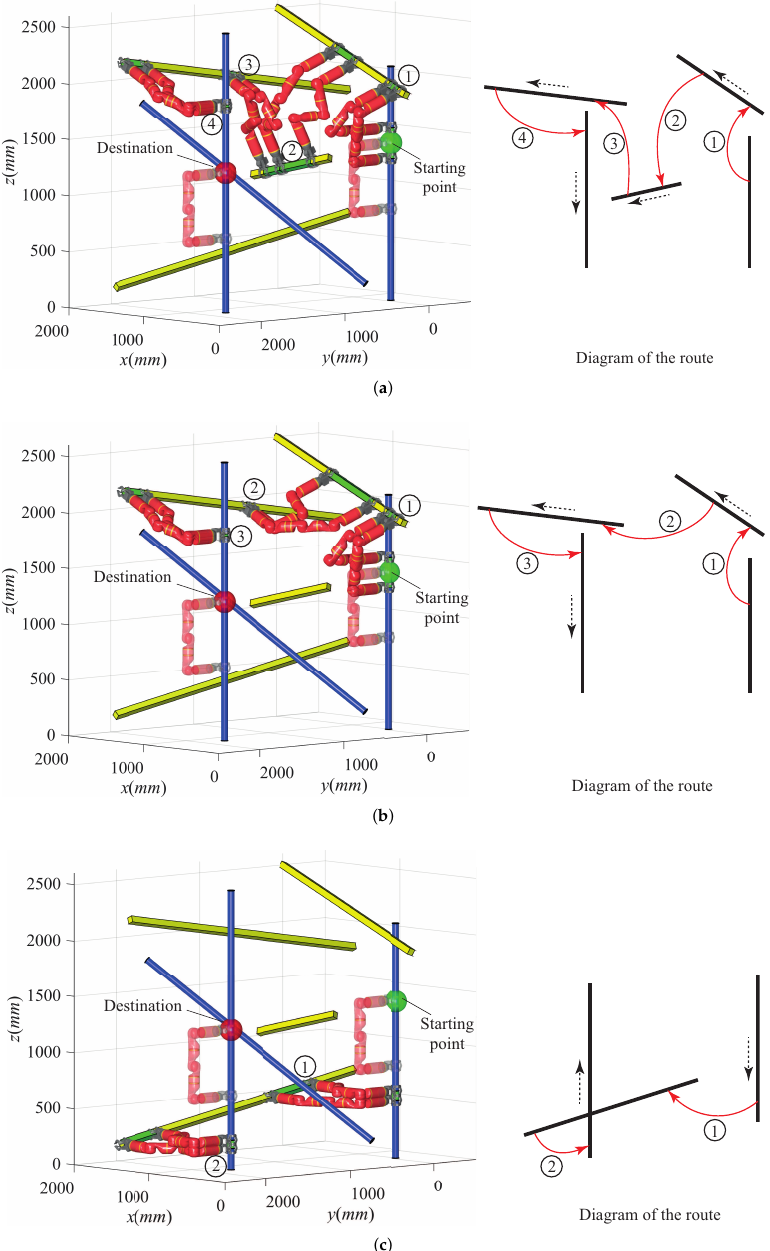
Figure 9. Results of global path determination in Scene I consisting of 7 members. (a) Route I; (b) Route II; (c) Route III.